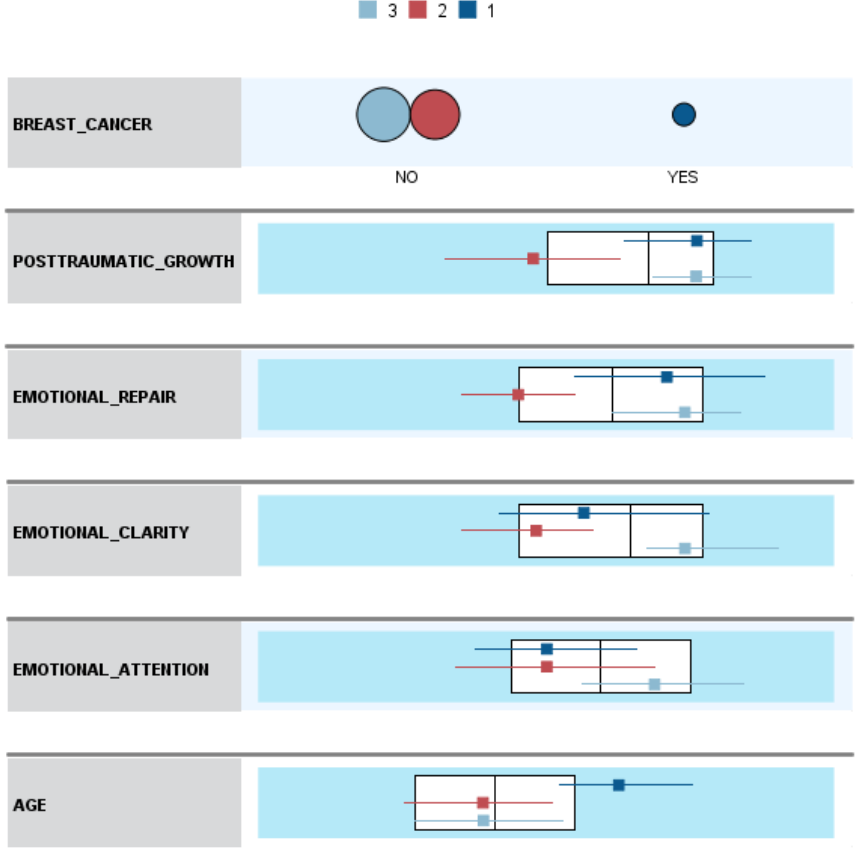
Figure 3. Comparison of clusters concerning breast cancer survivor and nonsurvivor status. Cluster 1 (N = 56; 8.8%). Older (M = 51.77) female breast cancer survivors with high levels of PTG (M = 77.09) and emotional repair (M = 30.32) and low levels of emotional attention (M = 24.50) and emotional clarity (M =